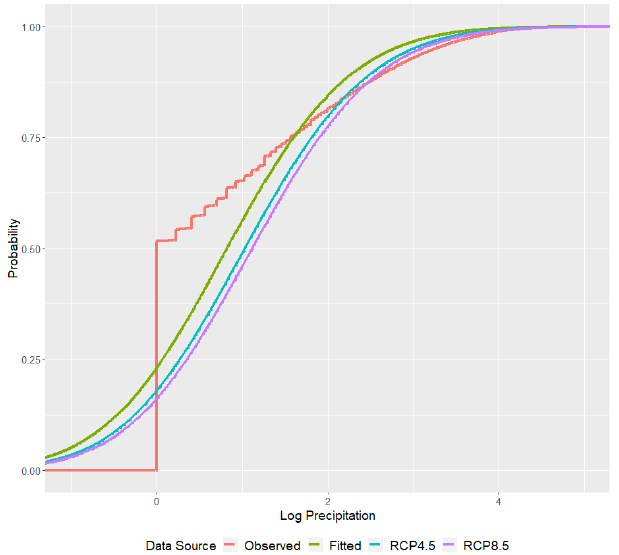
Figure 5. Log precipitation cumulative distribution function esti- mates of the observed (red curve), fitted (green curve), downscaled RCP4.5 (blue curve), and downscaled RCP8.5 (purple curve). Downscaled projections are derived from Canada’s CanESM2. This figure was created using Wickham